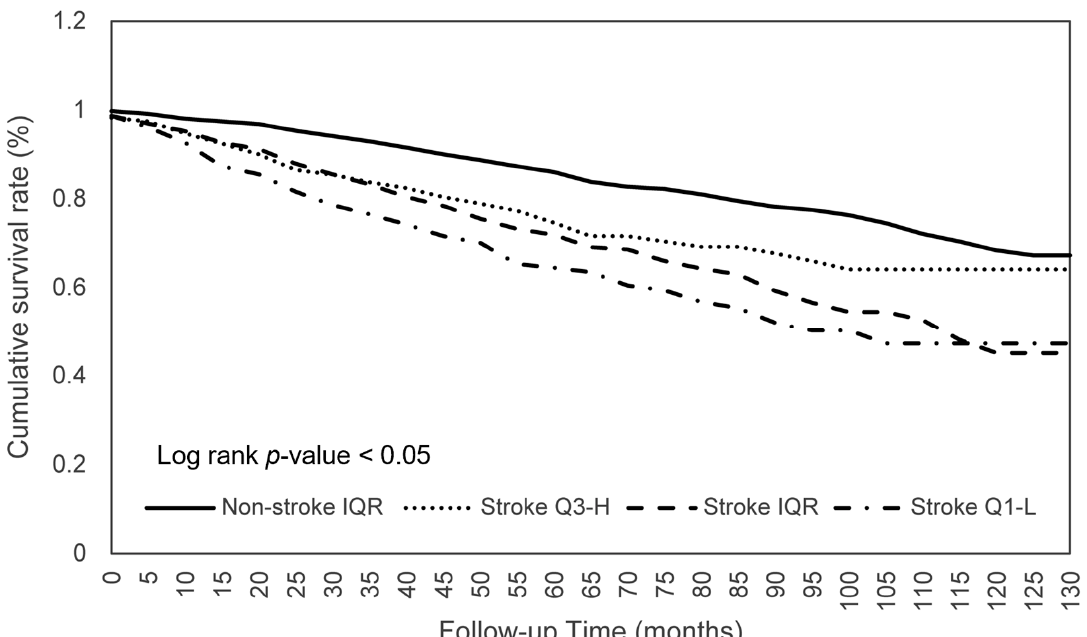
Figure 2. Protein consumption in relation to the cumulative mortality rates. Abbreviations: Q1-L, Q1-lowest; IQR, interquartile range; Q3-H, Q3-highest.